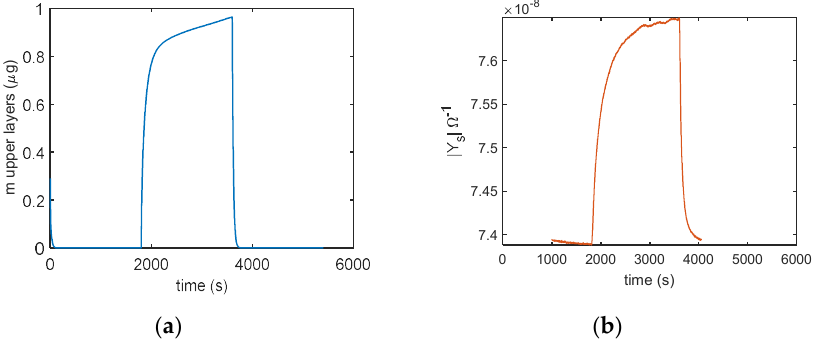
Figure 15. Comparison of ( a ) predicted adsorbed mass in the upper layer (model in Equation (5)) and ( b ) the sensor admittance magnitude measured at 100 Hz using the following protocol: RH = 0% (30 min), RH = 25% (30 min), and RH = 0% (30 min).